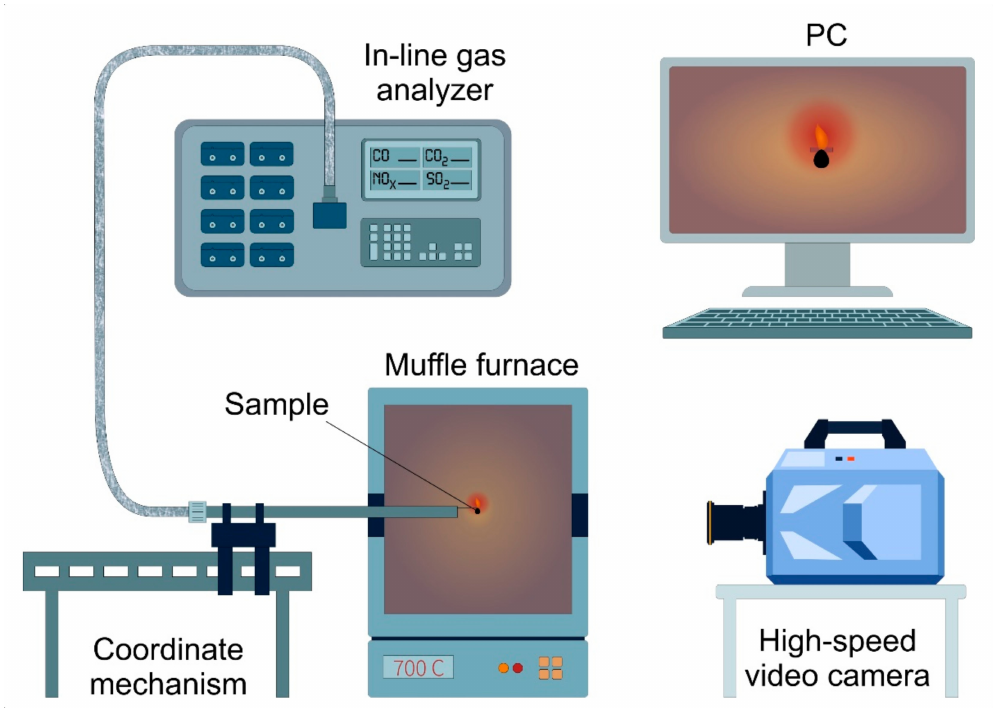
Figure 5. Experimental setup for studying droplet combustion of liquid